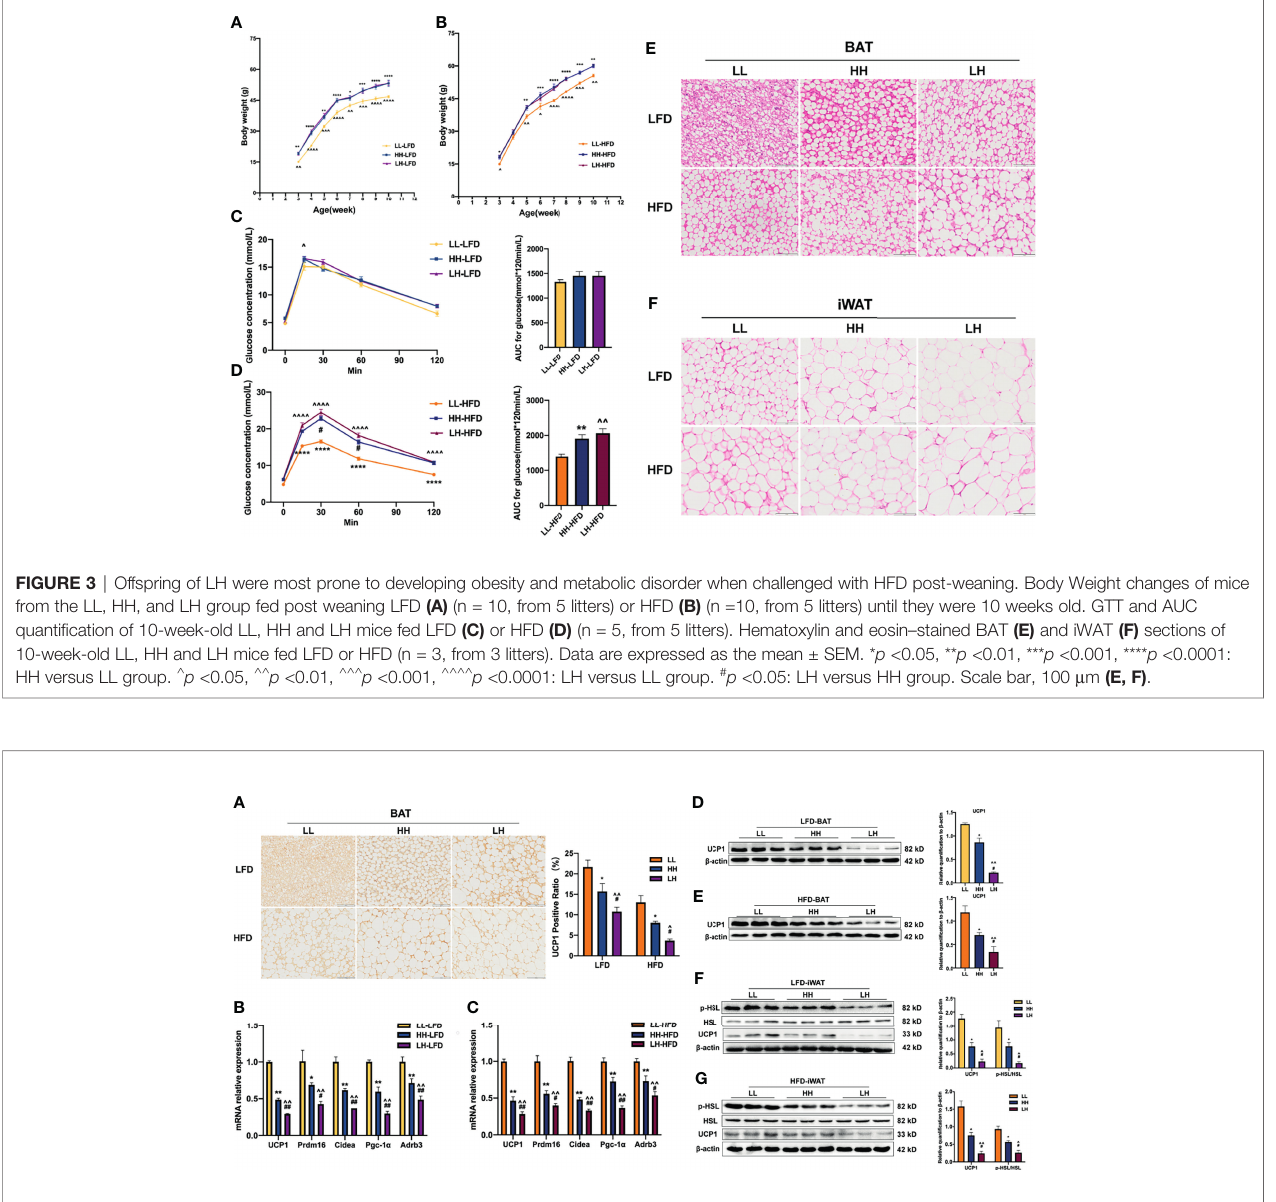
FIGURE 4 | Function of BAT was impaired in adult offspring of LH and HH, but LH seemingly more badly. (A) UCP1 staining for BAT sections of 10-week-old LL, HH and LH mice fed LFD or HFD (n = 3, from 3 litters) and UCP1 positive area. mRNA expressions of thermogenic genes in BAT when fed LFD (B) or HFD (C) (n =3, from 3 litters). Western blot analysis for thermogenic marker (UCP1) in BAT of adult LL, HH, and LH mice fed LFD (D) or HFD (E) (n =3, from 3 litters). Western blot analysis for UCP1, p-HSL and HSL in iWAT of adult LL, HH, and LH mice fed LFD (F) or HFD (G) (n = 3, from 3 litters). The fold increase was determined and normalized to b -ACTIN. Data are expressed as the mean ± SEM. * p < 0.05, ** p < 0.01: HH versus LL group. ^ p <0.05, ^^ p <0.01: LH versus LL group. # p < 0.05, ## p < 0.01: LH versus HH group. Scale bar, 100 m m (A) .